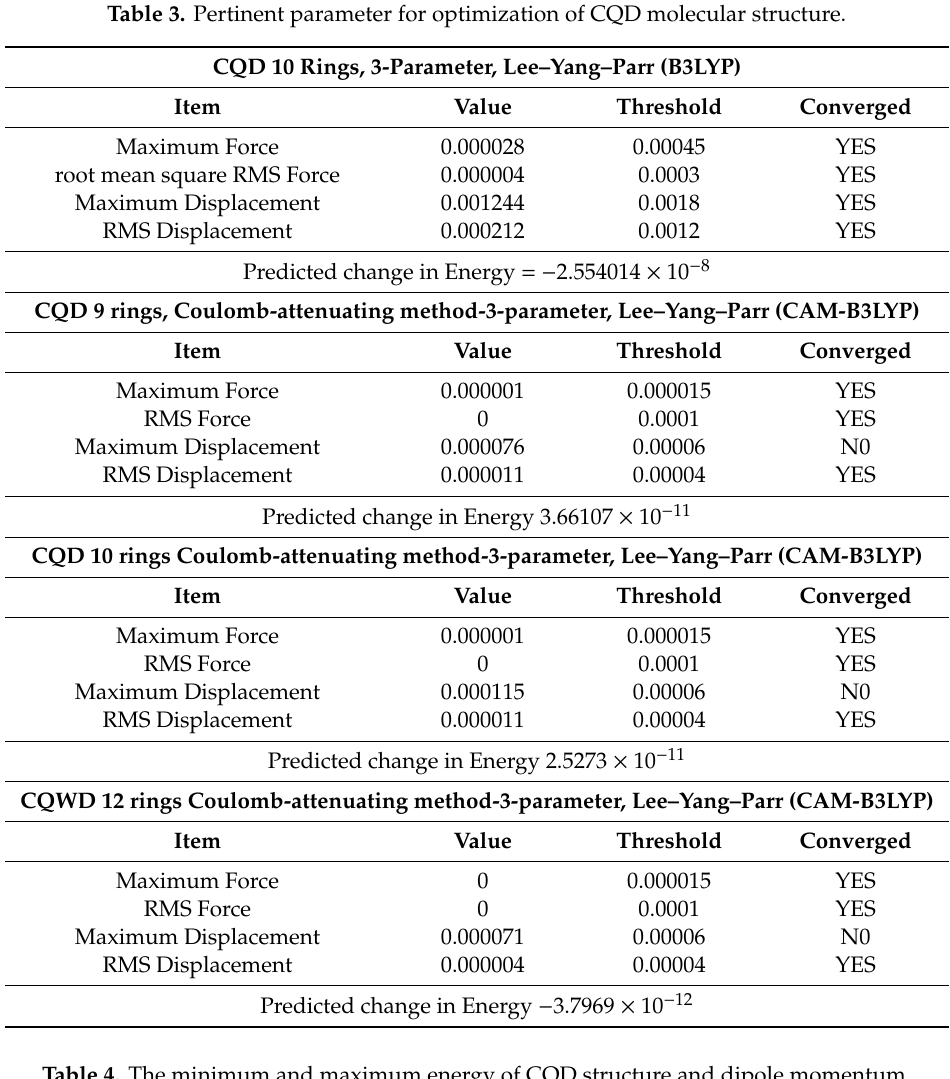
Table 4. The minimum and maximum energy of CQD structure and dipole